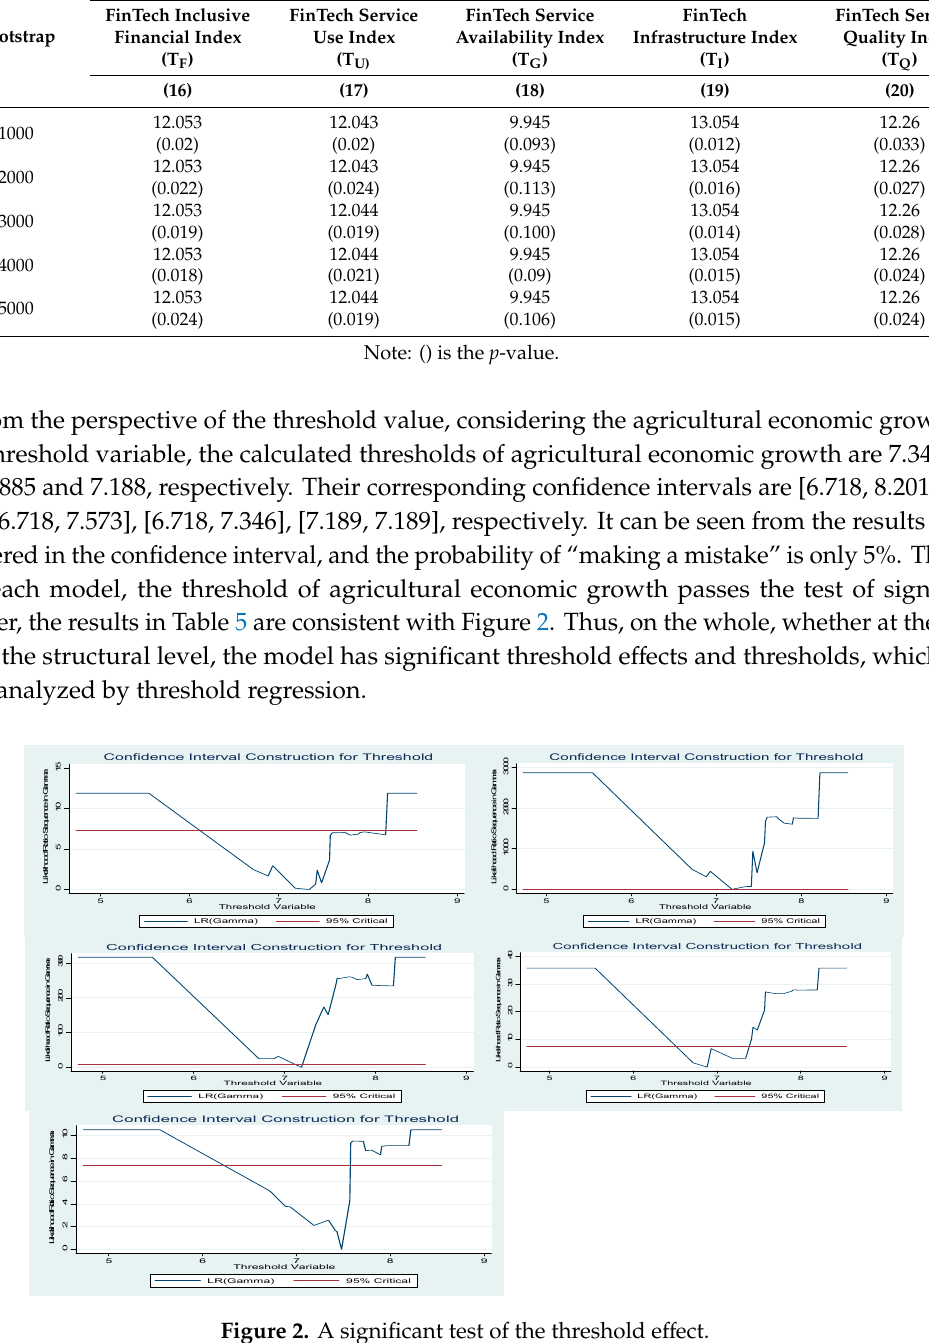
Figure 2. A significant test of the threshold effect.